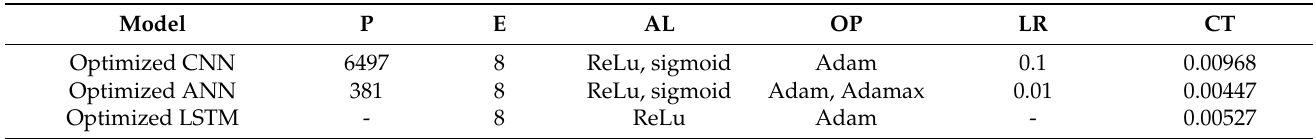
Table 2. Different algorithms’